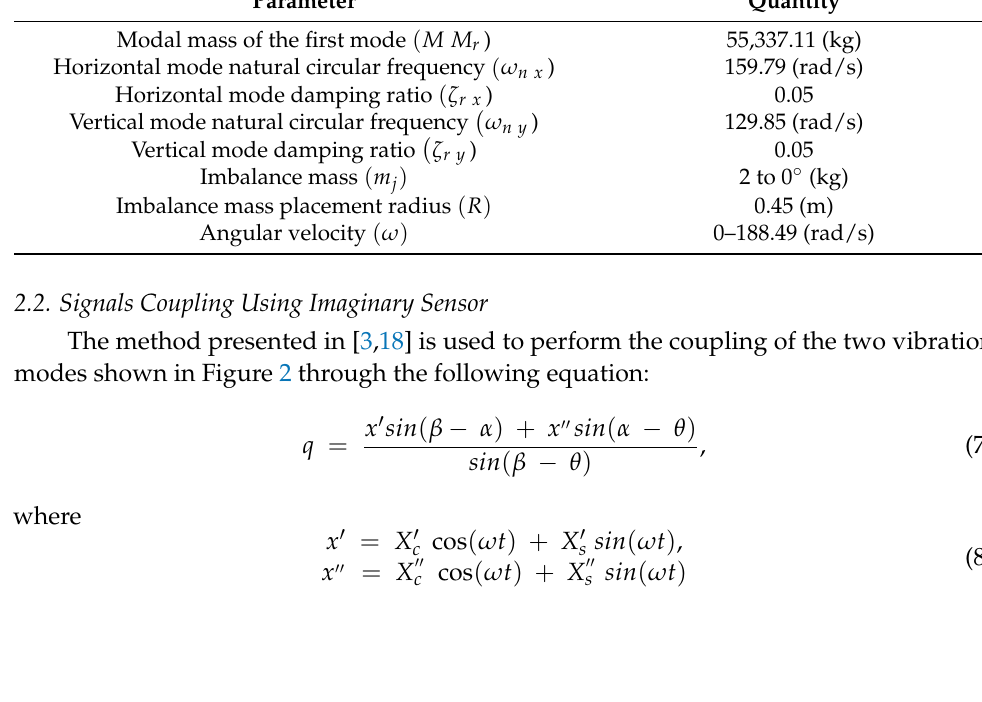
Table 1. Parameters for modeling the first vibration mode pair.